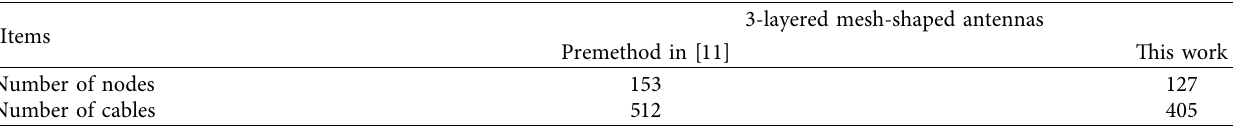
Table 5: Structural complexity comparison of the 3-layered mesh-shaped antennas before and after topology